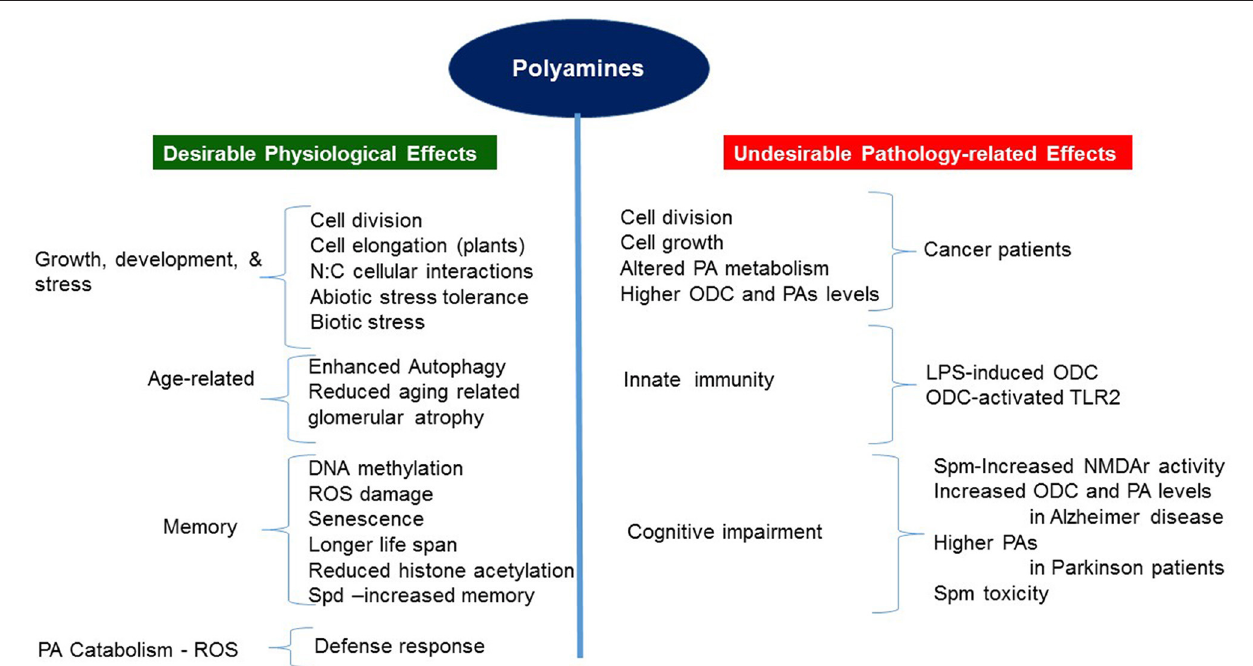
FIGURE 2 | Positive and negative aspects of polyamine function/role in plants and humans/animals.